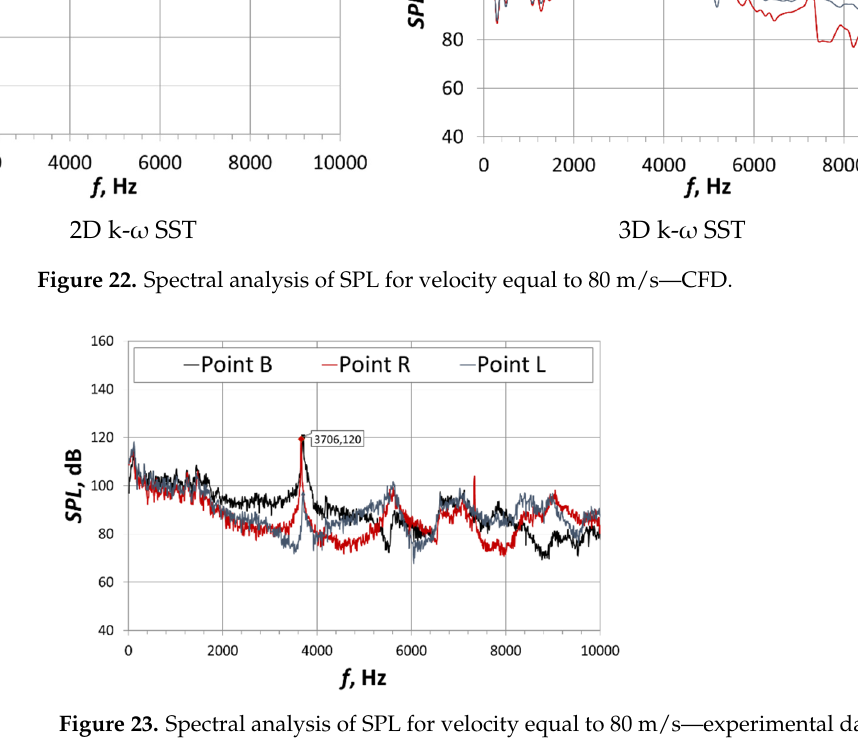
Table 2. Parameters of the generated acoustic wave for the velocity range 30–80 m/s. u ,